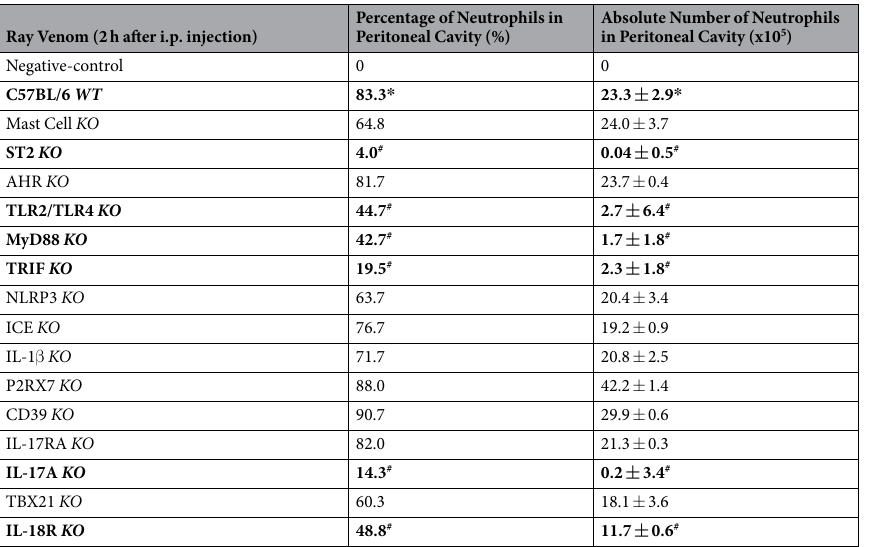
Table 1. Neutrophilia induced by ray venom is modulated by innate